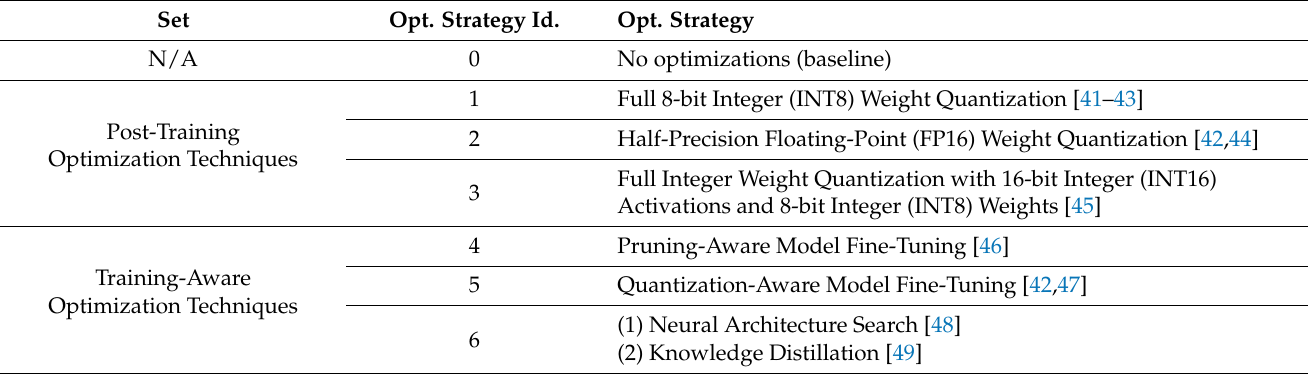
Table 3. Energy efficiency optimization